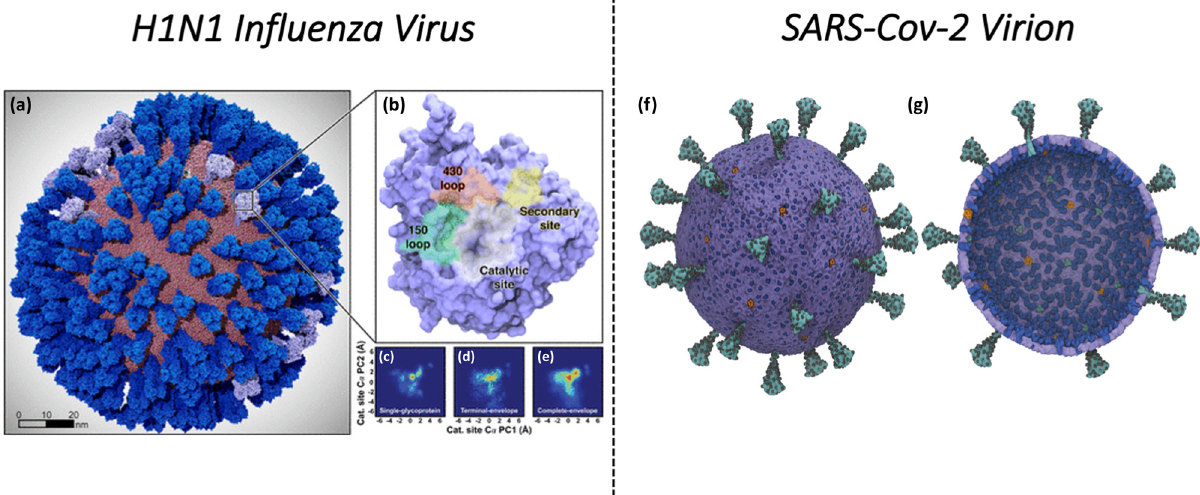
Figure 8: Computational virology applications: mesoscale simulations enhance conformational sampling of viral glycoproteins. AA - MD simulation of a fully intact all - atom model of the in fl uenza A H1N1 2009 ( pH1N1 ) viral envelope ( a ) . Hemagglutinin ( HA ) glycoproteins are shown in dark blue; neuraminidase ( NA ) glycoproteins are shown in light blue. In ( b ) , a single NA monomer is shown ( top view ) with its catalytic site ( white ) , secondary site ( yellow ) , 150 - loop ( green ) , and 430 - loop ( red ) . In ( c – e ) , principal component analysis ( PCA ) is performed by considering the motions of C atoms of 19 1° pocket residues. In ( c ) , the PCA of the four monomers is sampled during a single - NA - tetramer simulation. In ( d ) , the PCA of the 120 monomer trajectories is extracted during the last 8.33 ns of the viral envelope simulation. In ( e ) , the PCA of all 120 monomer simulations is extracted from the full simulation of the viral envelope. The fi gure has been adapted from Figure 1a – e from Durrant et al . [ 151 ] . In ( f ) and ( g ) , a multiscale model of the SARS - Cov - 2 virion is shown. An exterior view and an interior view of the SARS - CoV - 2 virion are given in ( f ) and ( g ) , respectively. The S - protein trimers are depicted in teal, with the glycosylation sites represented as black spheres. M - protein dimers are in blue, with pentameric E ion channels in orange. The experimental characterization addressed the appropriate density of S, M, and E proteins. The diameters of the membrane envelope span from 100 to 140 nm, including the S proteins on the virion surface. The fi gure has been adapted from Figure 3a and b of Yu et al . ( 2021 ) [ 316 ] .